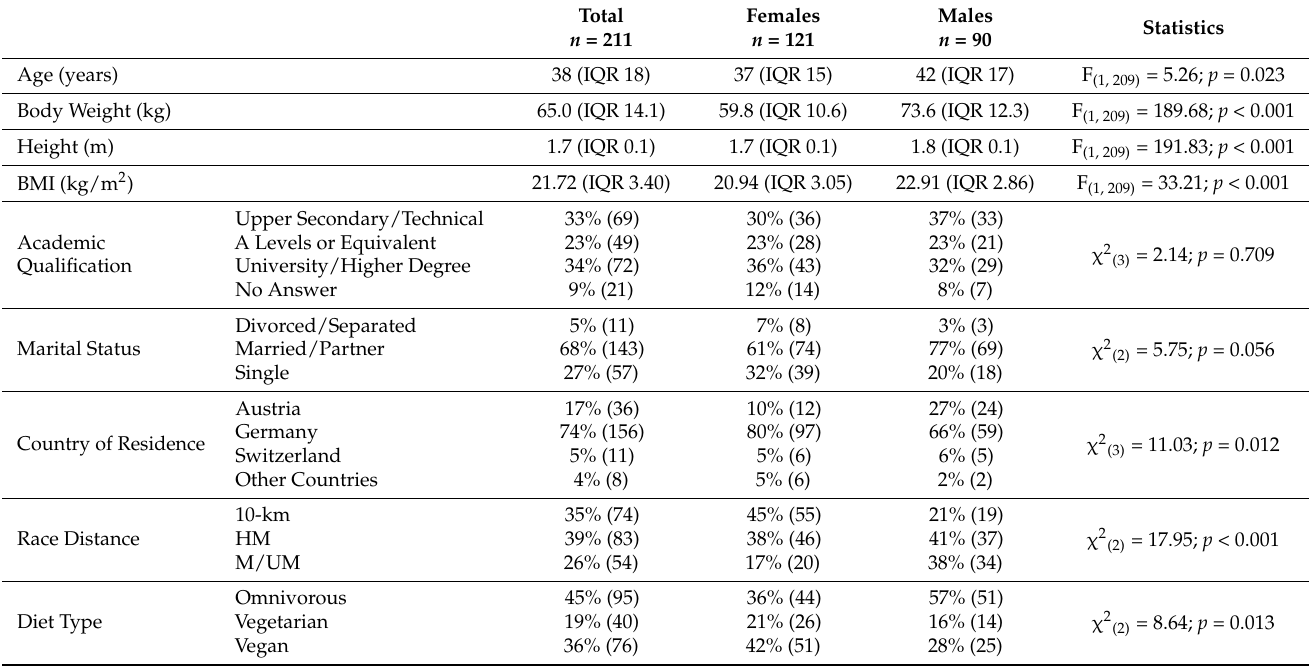
Table 2. Sociodemographic characteristics of female and male